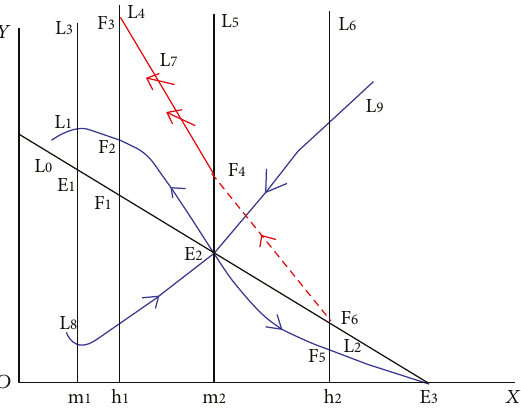
Figure 9: Structure diagram in R +